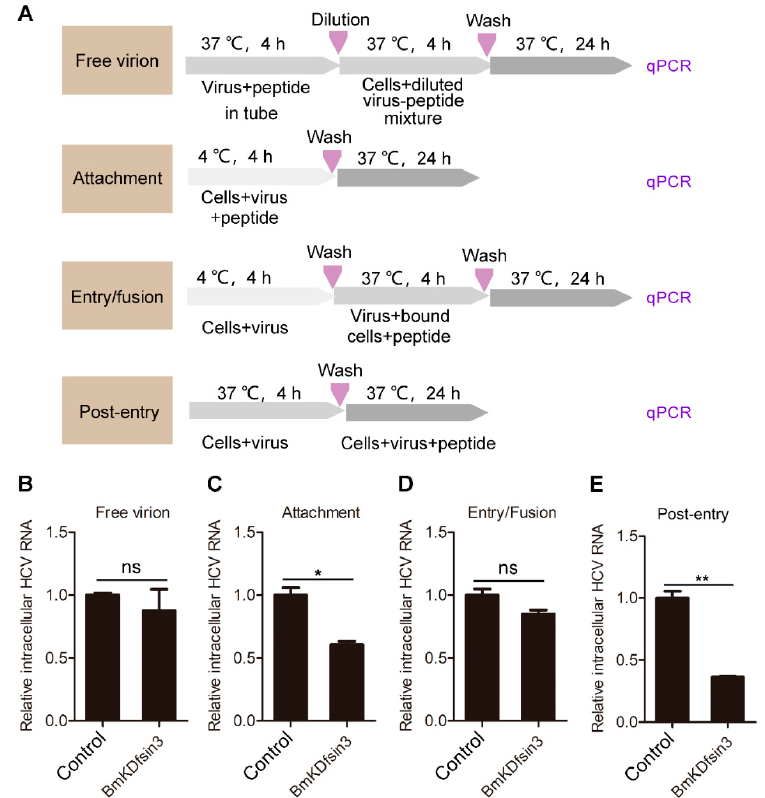
Figure 2. BmKDfsin3 a ff ects the attachment and post-entry stages during the HCV infection cycle. ( A ) Schematic diagram for studying the action stage of BmKDfsin3 on HCV. (B–E) The e ff ects